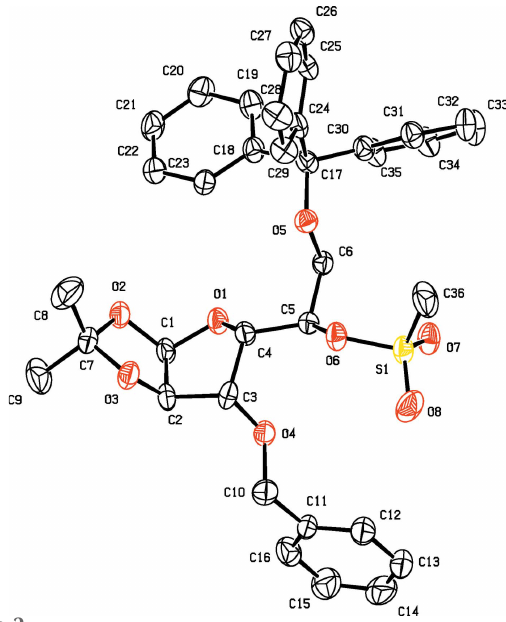
Figure 2 Aview of the molecular structure of compound 3 , with atom labelling and displacement ellipsoids drawn at the 30% probability level. For clarity, H atoms have been omitted.